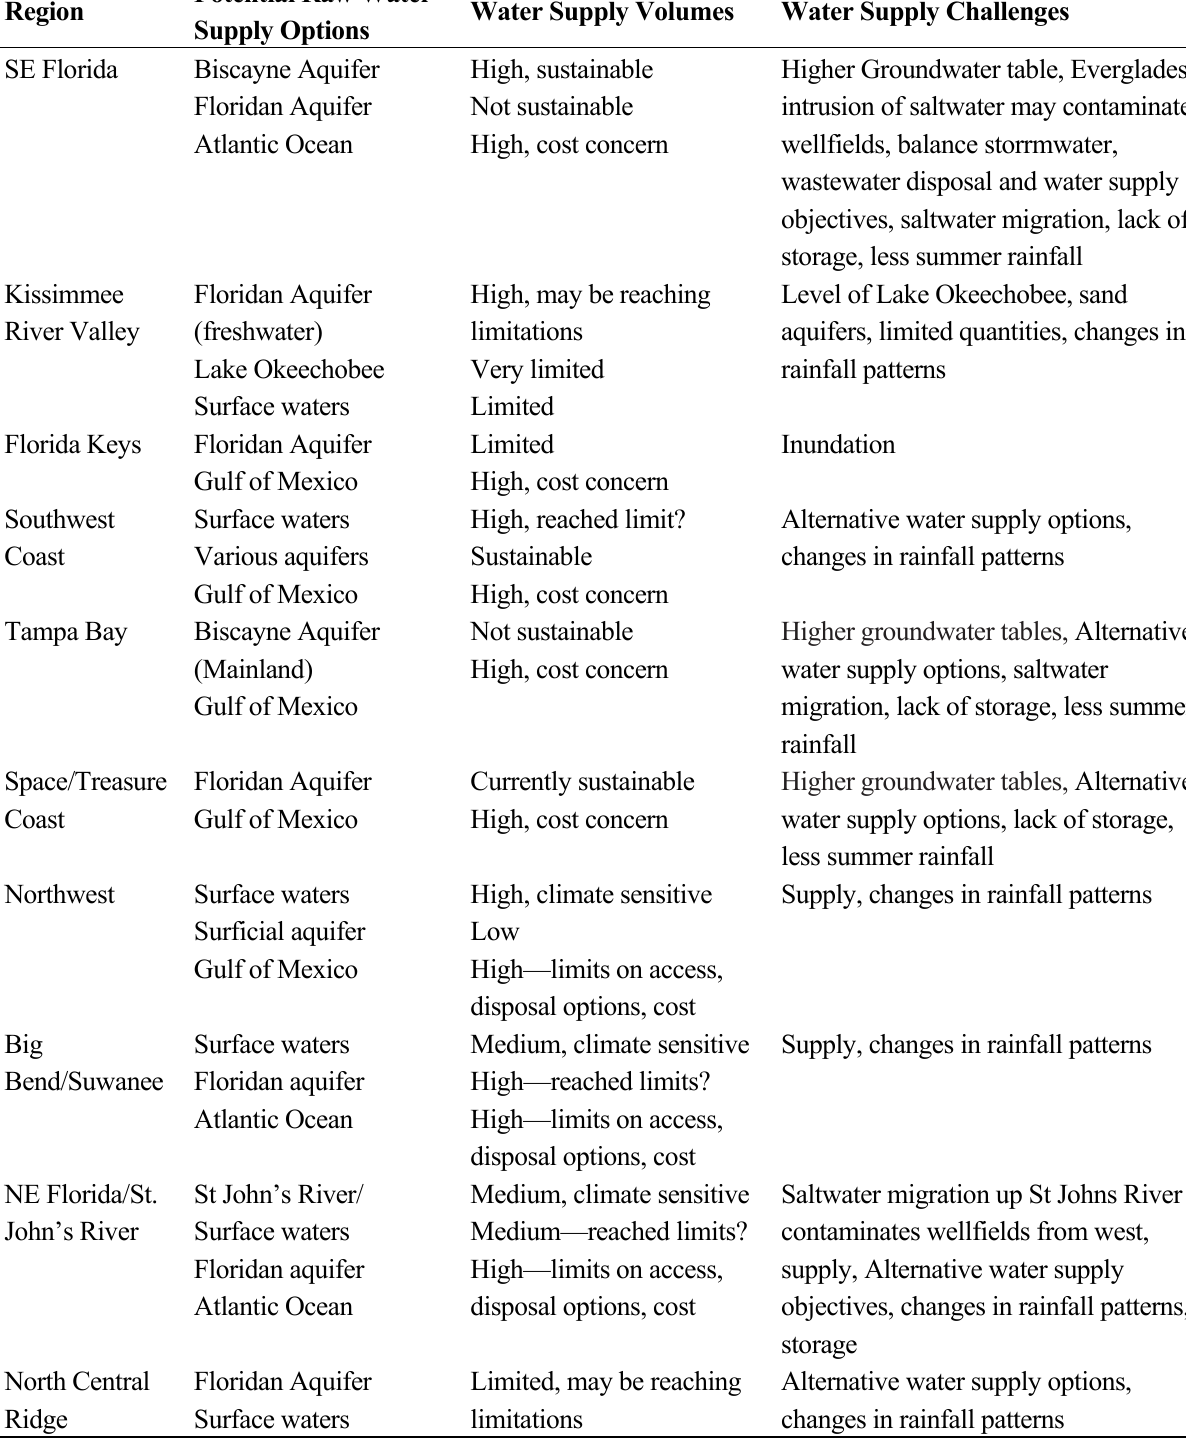
Table 2. Regions of the State, raw water supplies and water supply